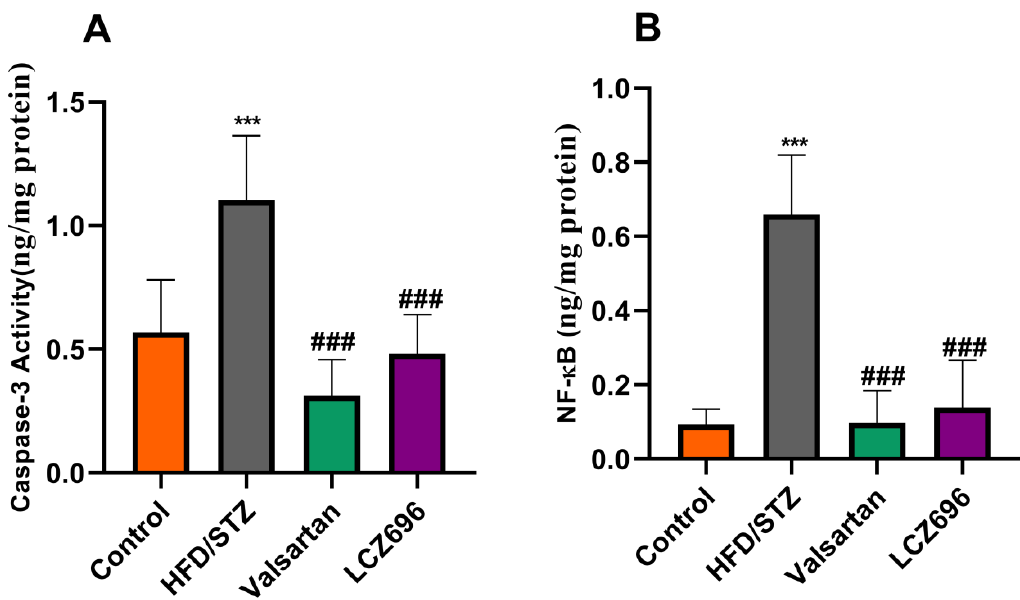
Figure 2. The effects of LCZ696 and valsartan treatment on caspase-3 activity ( A ) and NF- κB ( B ) in HFD/STZ-induced diabetic rats. The data are expressed as the mean ± SEM, n = 6, *** p < 0.001 versus control; ### p < 0.01 versus HFD/STZ. Abbreviations: NF- κB, nuclear factor kappa -B.